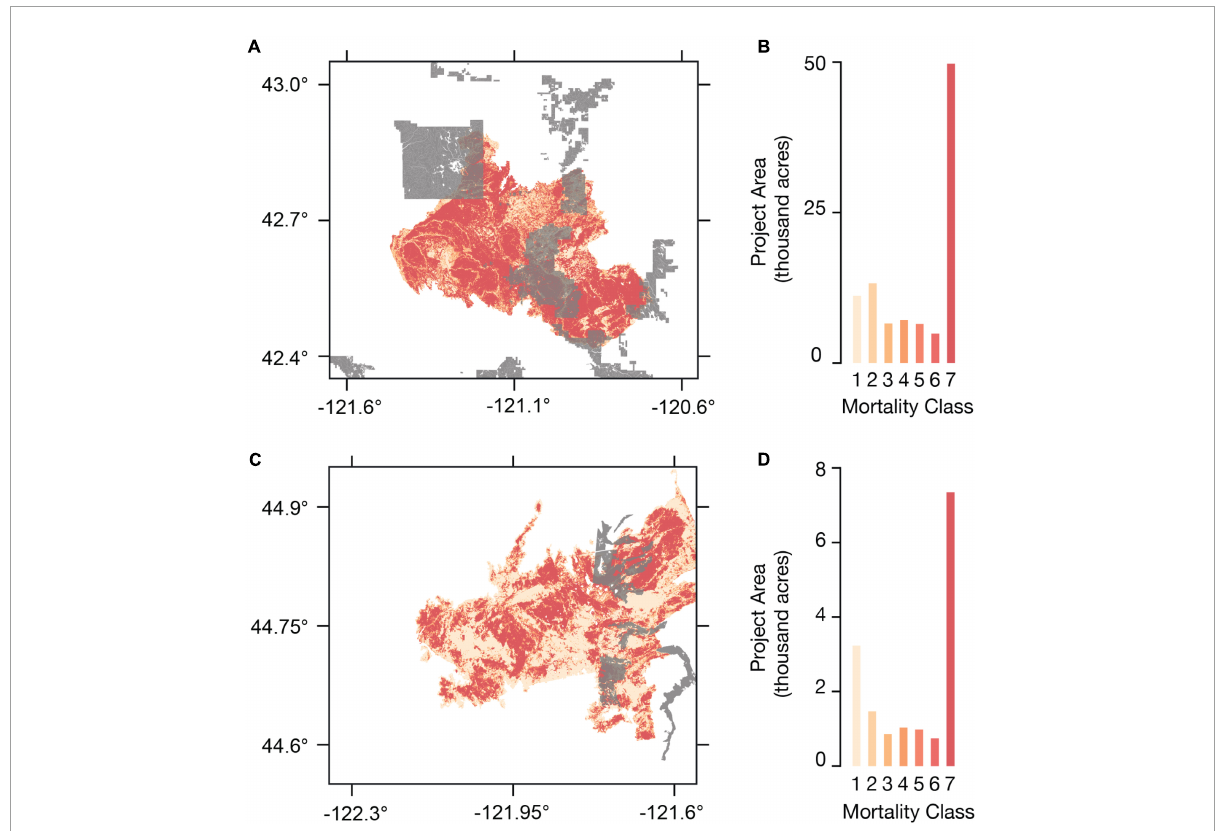
FIGURE2 Estimated fire mortality in ACR260 and ACR273. Panel (A) shows the overlay between the Klamath East project (ACR273) in gray and the 2021 Bootleg fire, with a summary of the United States Forest Service’s 7-class percent change in basal area data within the project area tabulated and shown in the same color shading in panel (B) . Panels (C,D) show the same information for the Warm Springs project (ACR260) and the 2020 Lionshead fire.